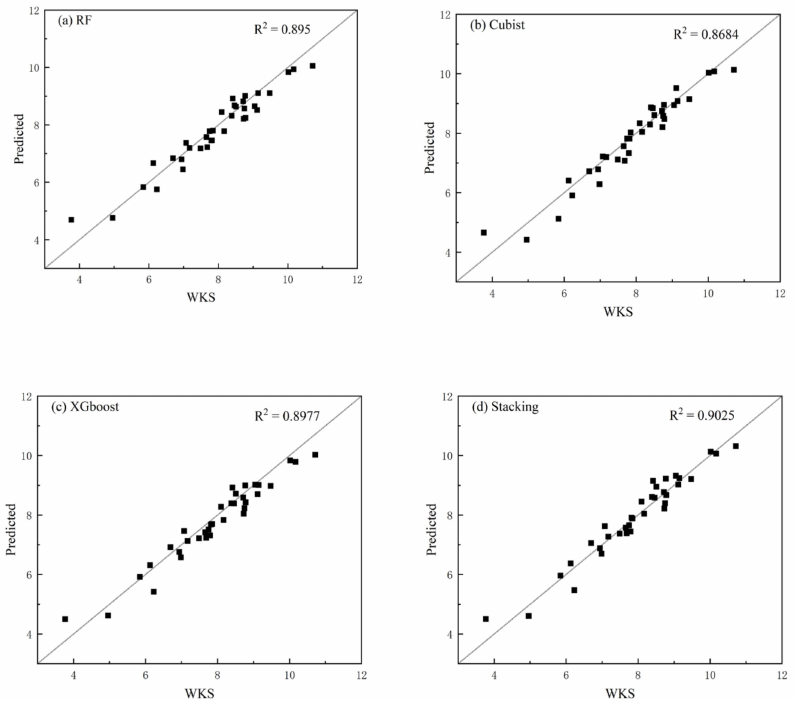
Figure 2. Scatter plot of the predicted and true values of ( a ) RF, ( b ) cubist, ( c ) XGBoost, and ( d ) stacking models. (note: predicted and true values of the models are both